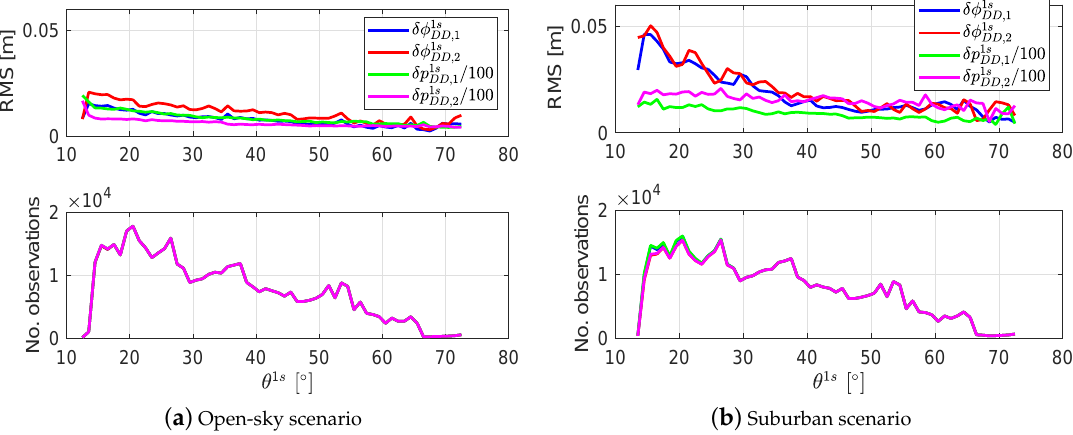
Figure 2. Root Mean Squares (RMS) of the double-difference (DD) residuals with respect to the elevation angles ( θ 1 s ) in: ( a ) the open-sky scenario and ( b ) the suburban scenario. Note that the RMS of the code residuals is divided by a factor of 100. In the bottom panels, the blue, the red and the green lines are almost overwritten by the magenta